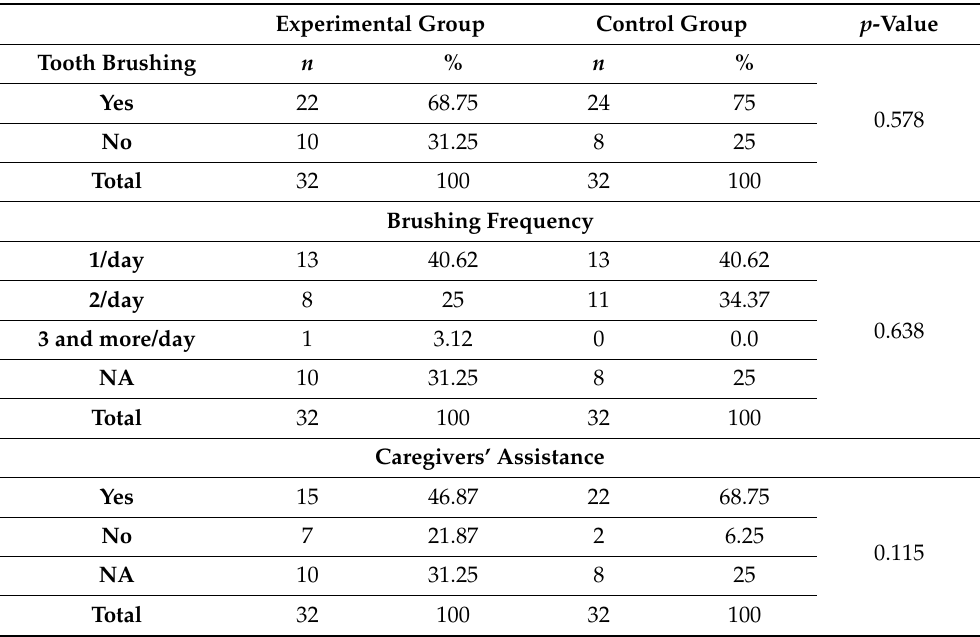
Table 3. Distribution of Tooth Brushing, Frequency, and Caregivers’ Assistance Among Children with ASD. Experimental Group Control Group